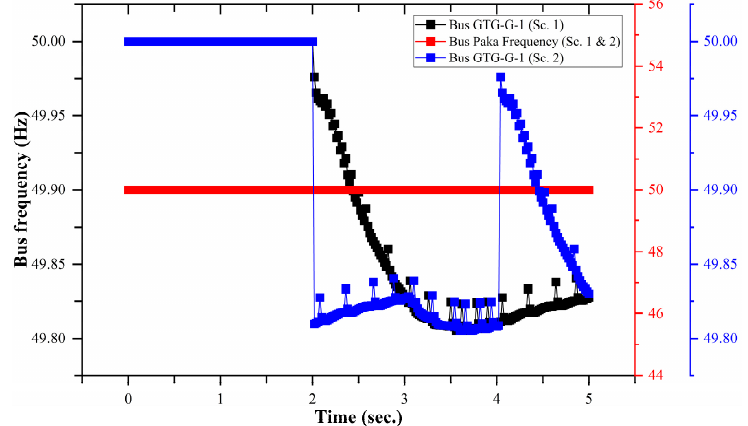
Figure 7. Bus frequency of the test system for under frequency (Scenario 1 and Scenario 2).